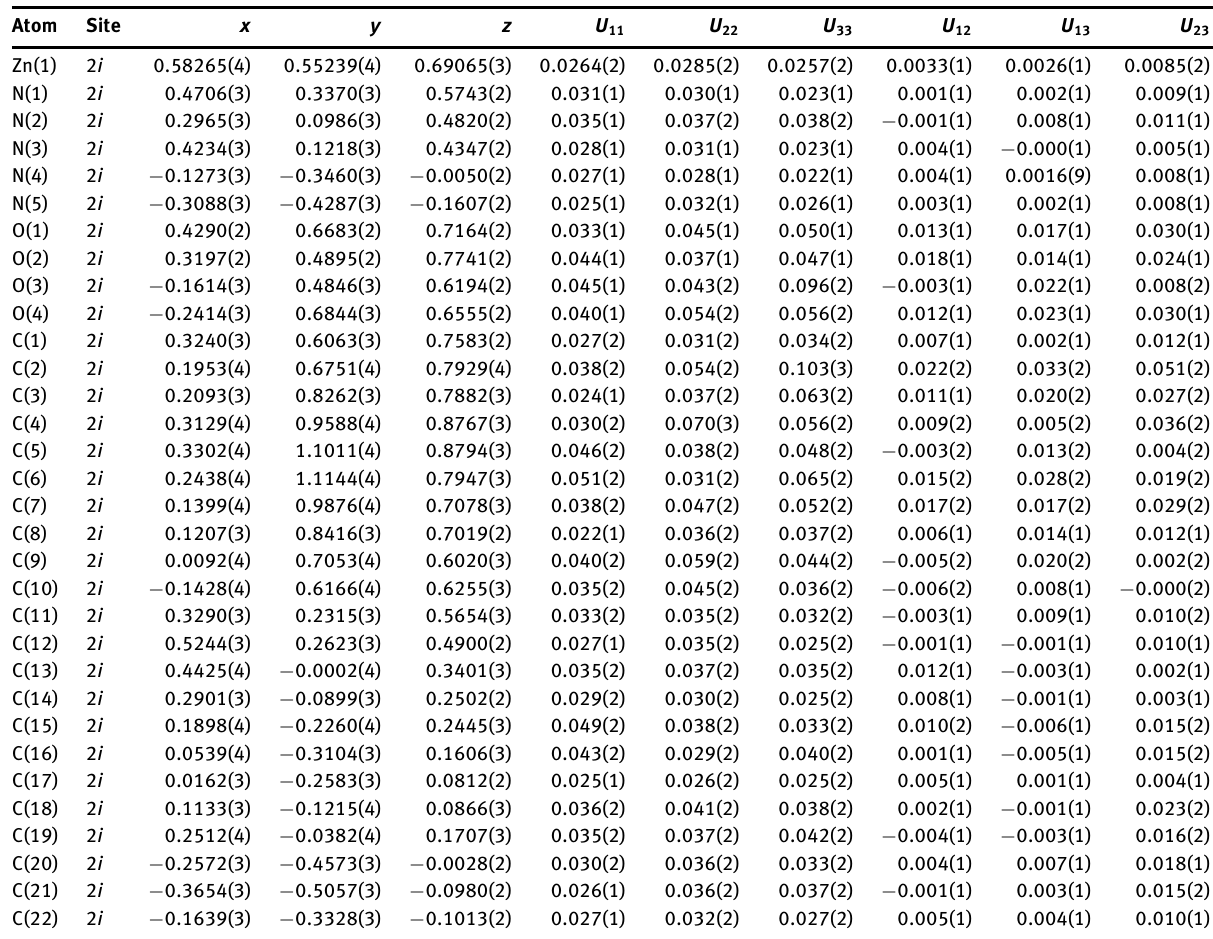
Table 3: Fractional coordinates and atomic displacement parameters (Å 2